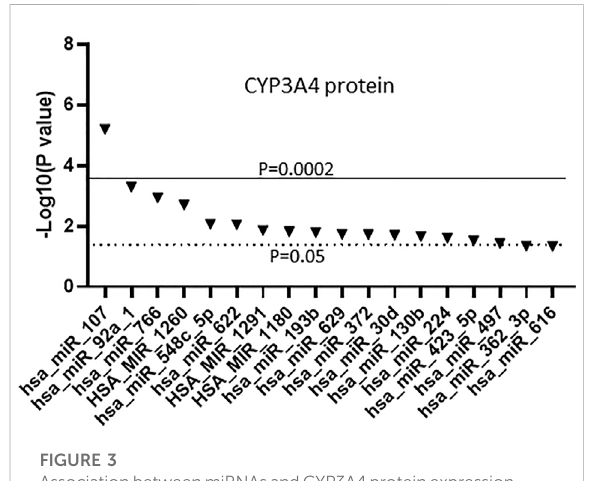
FIGURE 3 AssociationbetweenmiRNAsandCYP3A4proteinexpression inhumanliversamples.miRNAsweremeasuredusingTheTaqMan OpenArray Human MicroRNA panels. Linear regression was used to test the association between the 247 measured miRNAs and CYP3A4 protein expression. Only miRNAs with an association p ≤ 0.05 are shown.